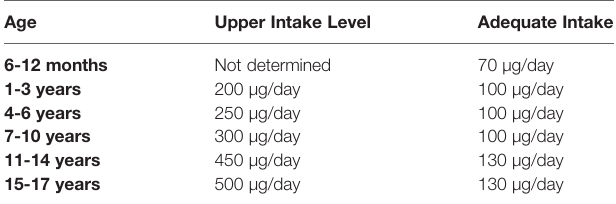
TABLE 4 | Reference of iodine values by age for Italian population